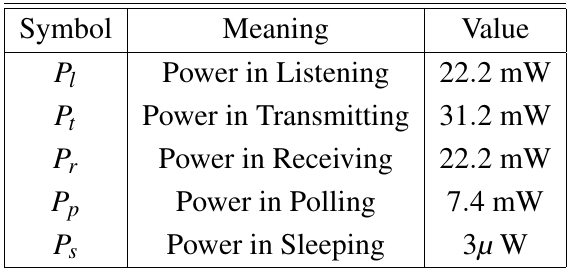
Table 2. Typical power values used in Mica2 radio